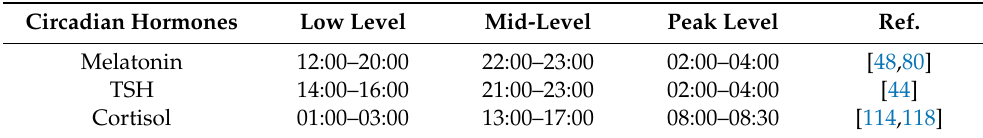
Table 3. Secretion pattern based on the circadian